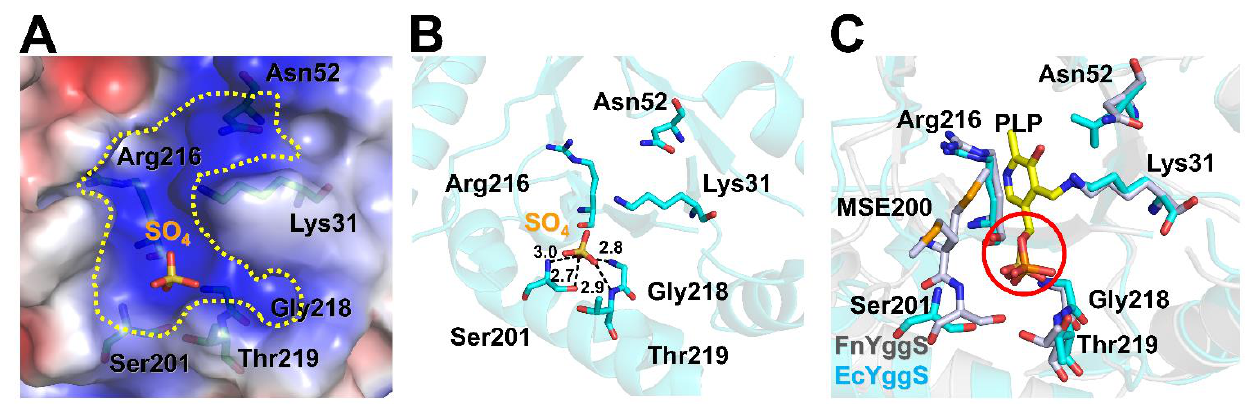
Figure 3. PLP-binding site and mutagenesis of FnYggS. ( A ) Electrostatic surface of the PLP-binding site of FnYggS. ( B ) The sulfate ion in the PLP-binding pocket of FnYggS is coordinated by Ser201, Gly218, and Thr219. ( C ) Superimposition of the PLP-binding site of FnYggS (purple) onto PLP-bound EcYggS (cyan, PDB ID: 1W8G).